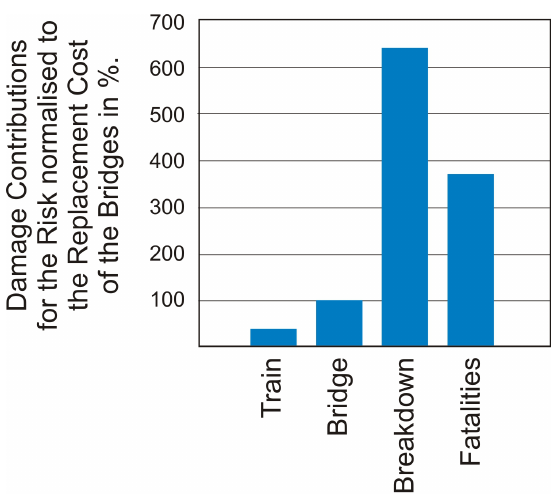
Figure 6. Normalised damage